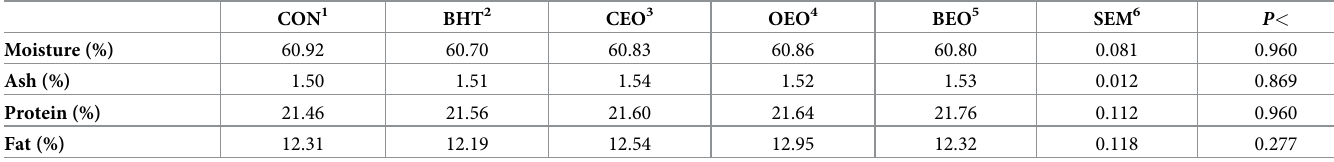
Table 1. Chemical composition of beef patties treated with BHT, copaiba and oregano essential oil or blend of essential oils. CON 1 BHT 2